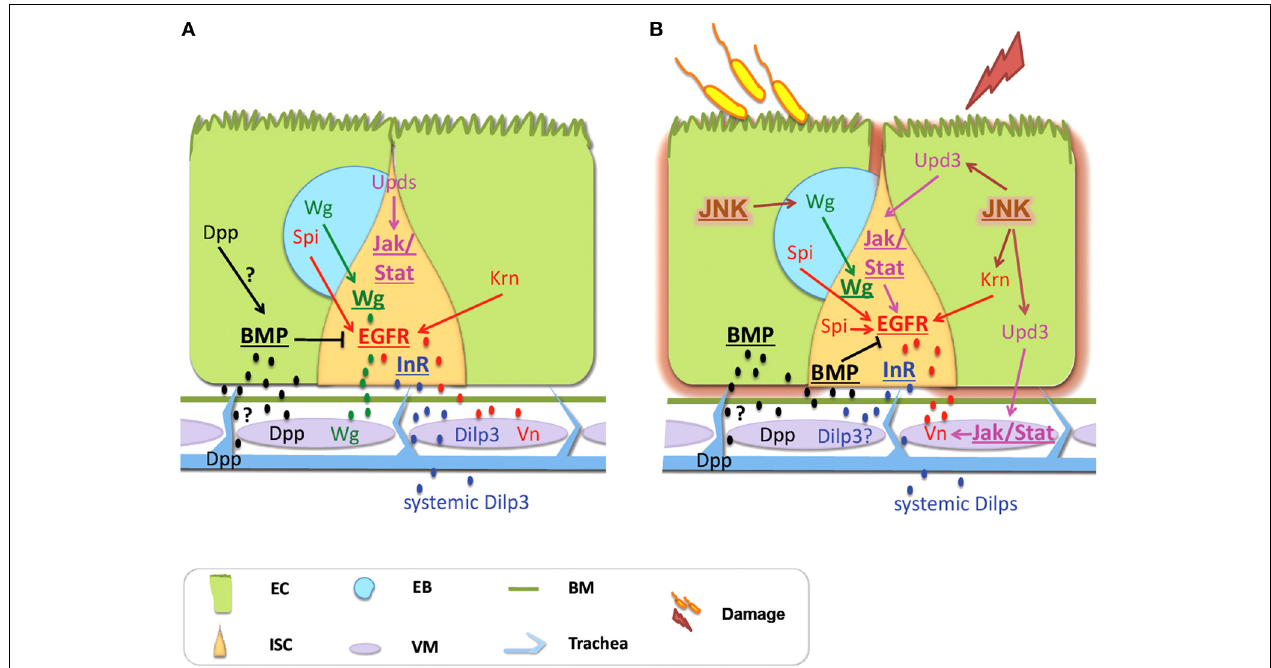
FIGURE 2 | Signals derived from non-intestinal epithelial tissues control intestinal homeostasis in Drosophila. (A) Physiological Homeostasis: Basal proliferation is controlled via the EGFR and the Wg pathways, whereas JAK/STAT controls differentiation. Vn secreted by the VM, as well as Krn and Spi coming from the EC and the EB, respectively, activate the EGFR pathway. Wg coming from the VM and the EB activates the Wg pathway. Dilp3 secreted from the VM and systemic Dilps activate InR signaling in response to nutrition. Dpp secreted by the VM and possibly by the ECs and the trachea activates the BMP pathway, which inhibits EGFR. Differentiation is regulated by JAK/STAT with the Upd cytokines coming mainly from the ECs. (B) Regenerative inflammatory signaling: Enteric infection and ingestion of chemicals induce intestinal damage that promotes regeneration via compensatory ISC proliferation. The EGFR, the Wg and the JAK/STAT